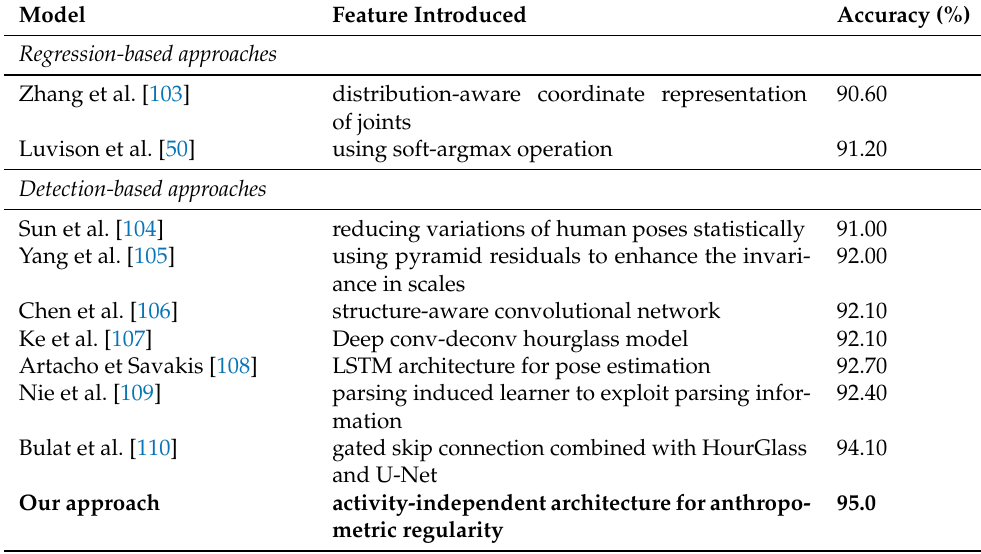
Table 7. Model performance using MPII